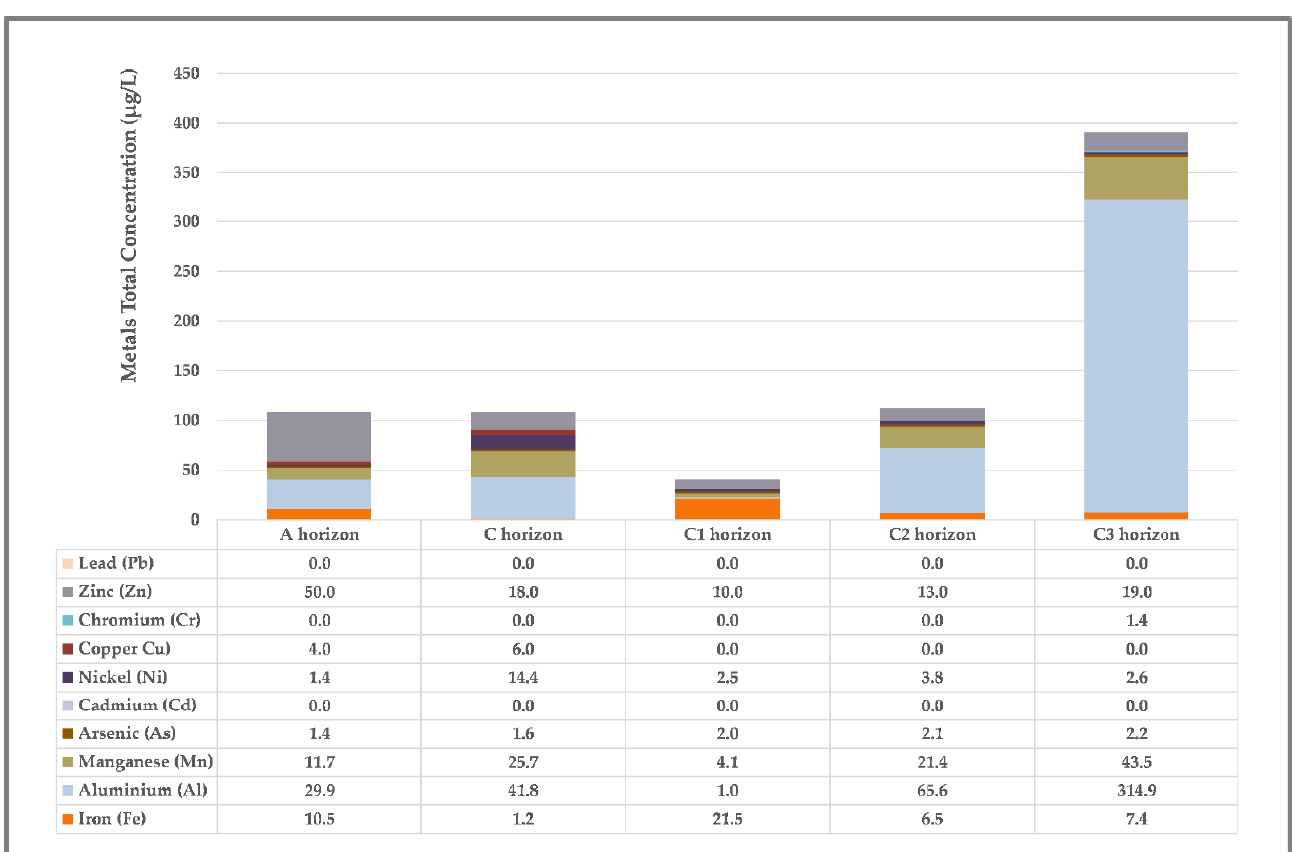
Figure 6. Concentration of PTEs and Fe in soil leachates from São Pedro da Cova mine waste pile.